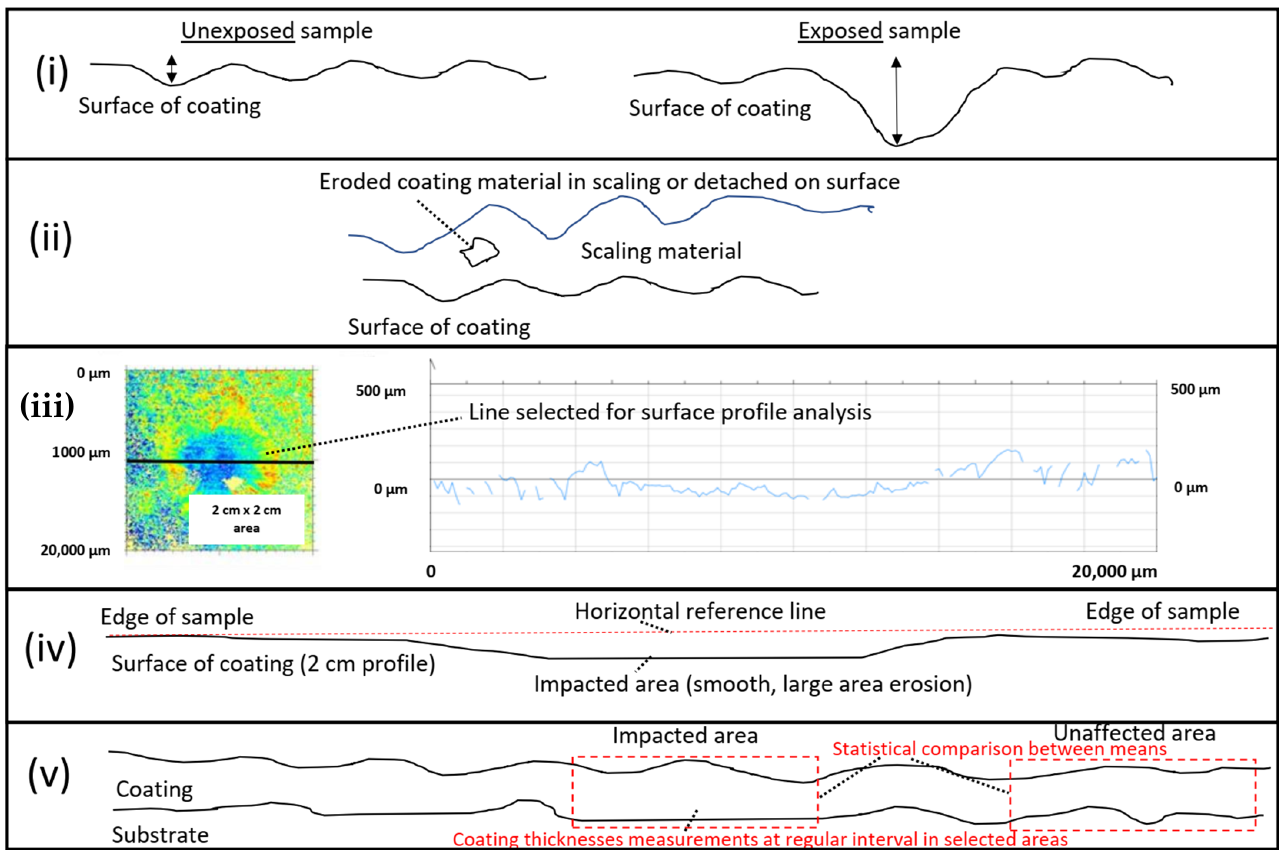
Figure 1. Methods for erosion assessment in our study: ( i ) erosion pit and shape comparison with an unexposed sample, ( ii ) coating material detached from the surface or within scaling, ( iii ) roughness measurements with optical profilometry, ( iv ) analysis with horizontal line adjacent to 20 mm length surface by image splining, and ( v ) statistical analysis of coating thicknesses in impacted area vs. unaffected area.